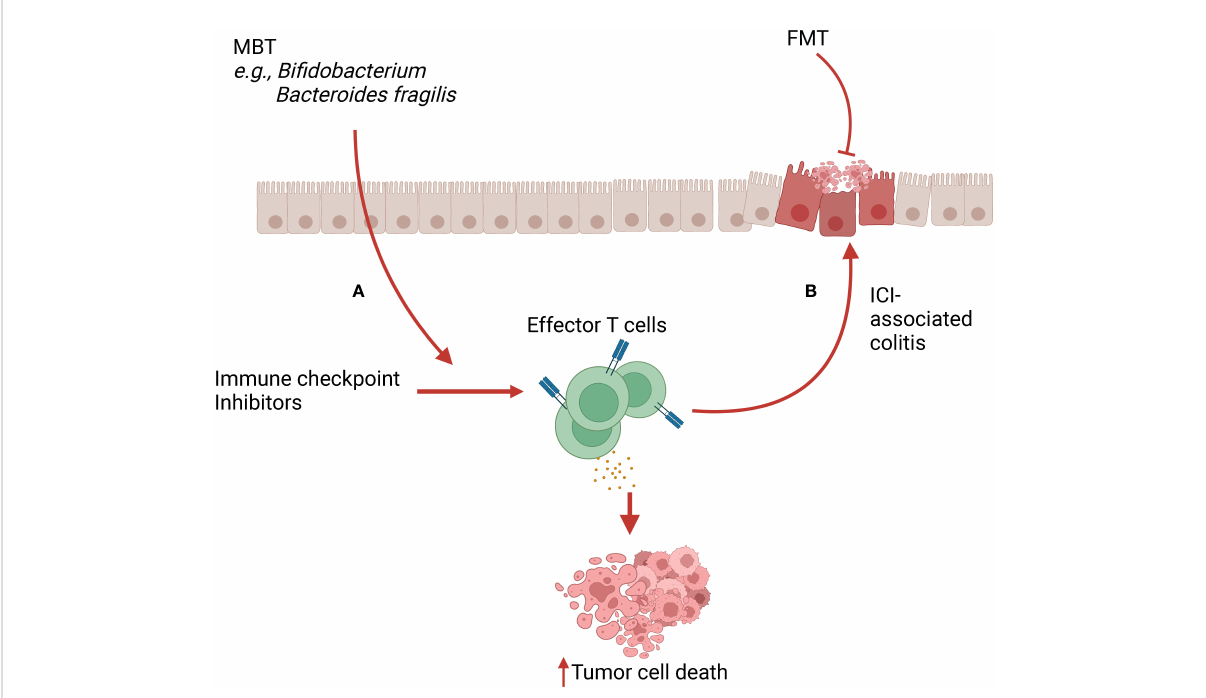
FIGURE 2 Microbiome-based therapy (MBT) in immune checkpoint inhibitor (ICI) therapy and ICI-associated colitis. (A) MBTs such as Bi fi dobacterium spp and Bacteroides fragilis cooperate with ICI, leading to increased in fi ltration and activation of effector T cells in the tumor microenvironment (TME). This mechanism boosts the anti-tumor activity of ICI therapy. (B) Activated T cells and their released cytokines induced by ICI therapy can cause off- target in fl ammation, leading to ICI-associated colitis. FMT can alleviate this ICI-associated colitis via inducing immunoregulatory